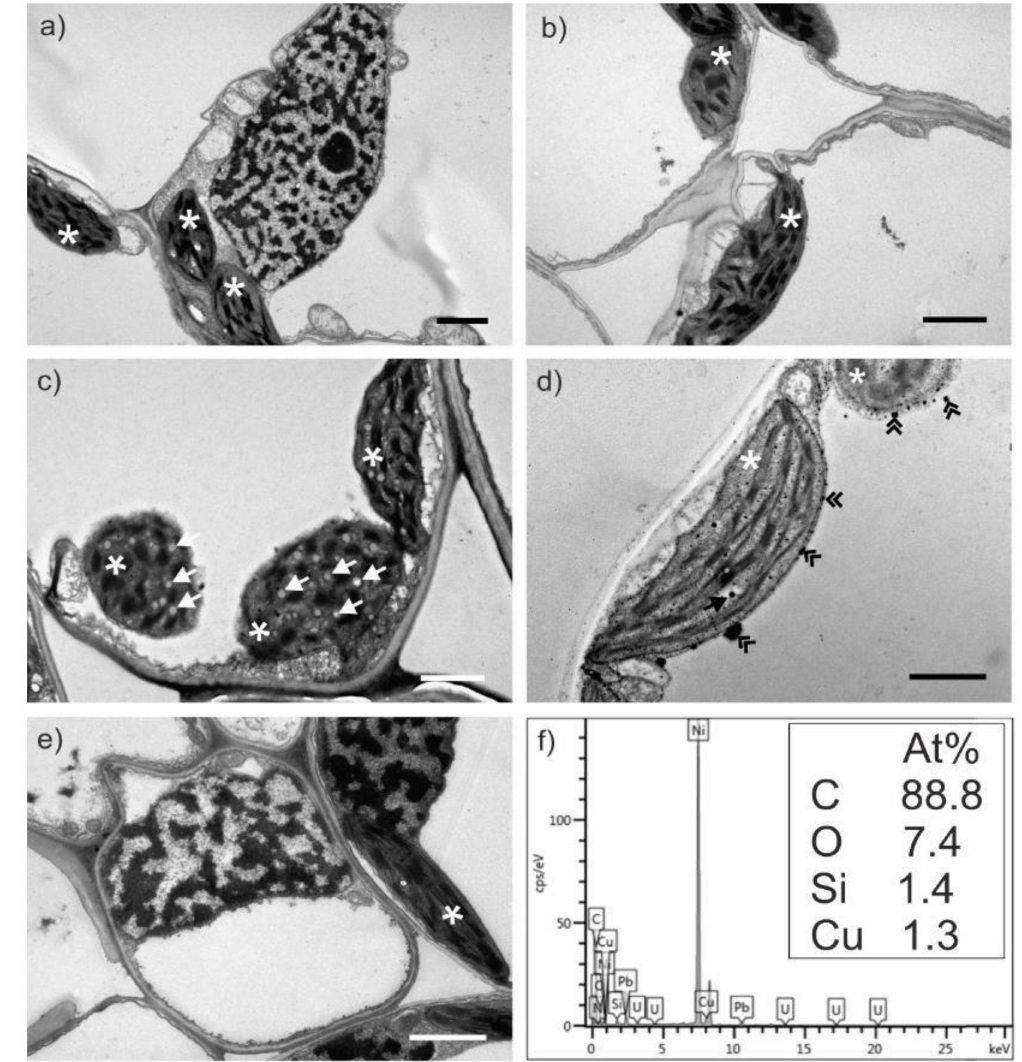
Figure 5. TEM micrographs of Triticum aestivum leaves treated with Cu(NO 3 ) 2 solution: 60 mg at three weeks ( a ) and six weeks ( b ), and 120 mg at three weeks ( c ) and six weeks ( d ); untreated controls leaves ( e ); EDX analysis of 120 mg treated plants for six weeks ( f ) indicating Cu accumulations in the electron dense particles (double arrowheads). After six weeks the wheat plants start to develop starch granules (simple arrow) inside the chloroplasts (asterix). All bars are at 2 µ